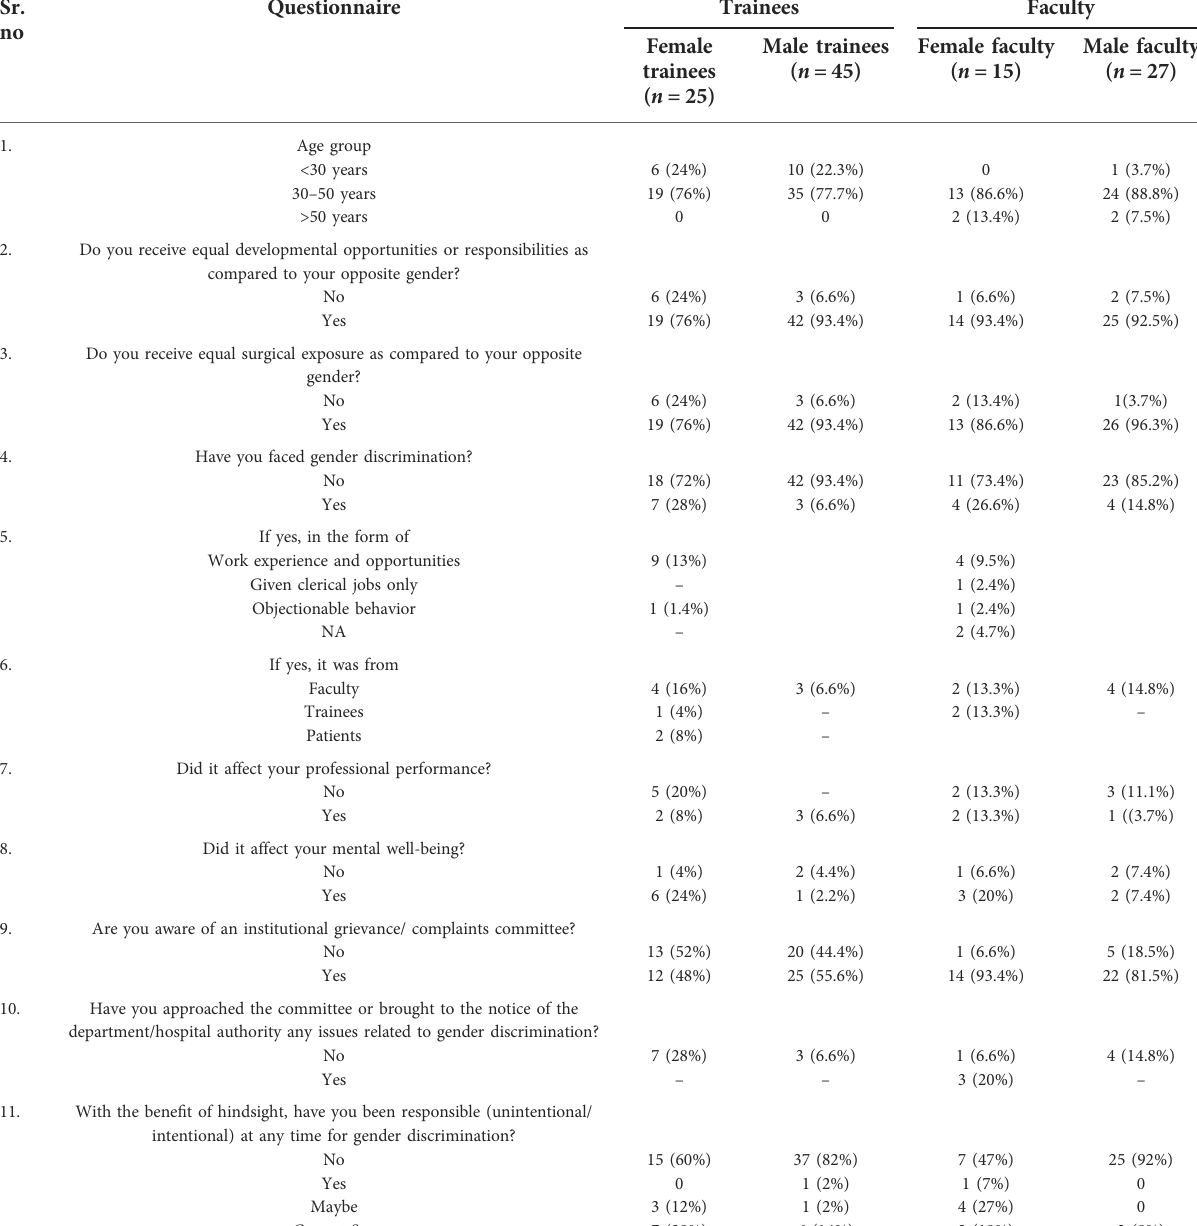
TABLE 1 Responses of trainees and faculty to the questionnaire. Sr.